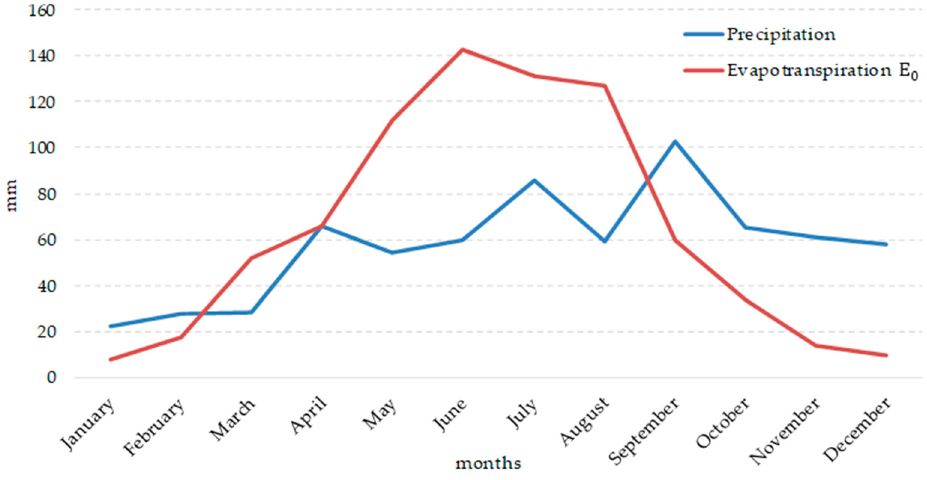
Figure 1. Monthly average of evapotranspiration and precipitation for the whole area in 2017.